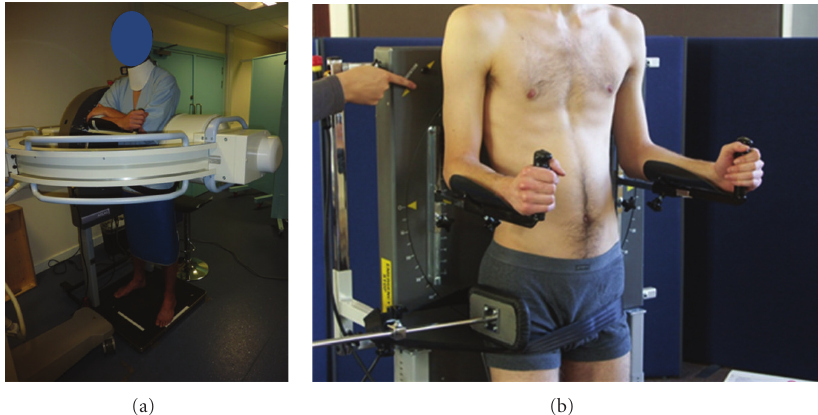
Figure 2: (a) Weight-bearing flexion-extension image acquisition following an upright motion frame. (b) Weight-bearing side-bending acquisition: position of motion